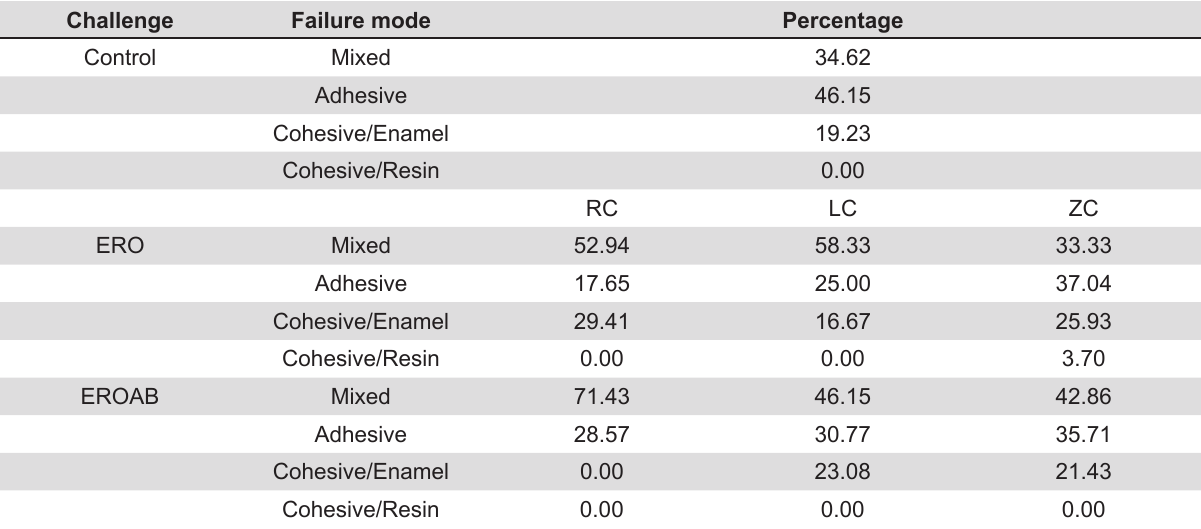
ERO-RC=eroded with regular Coke; ERO-LC=eroded with Light Coke; ERO-ZC=eroded with Zero Coke; NO=not abraded and AB=abraded; RC=regular Coke; LC=Light Coke; ZC=Zero Coke